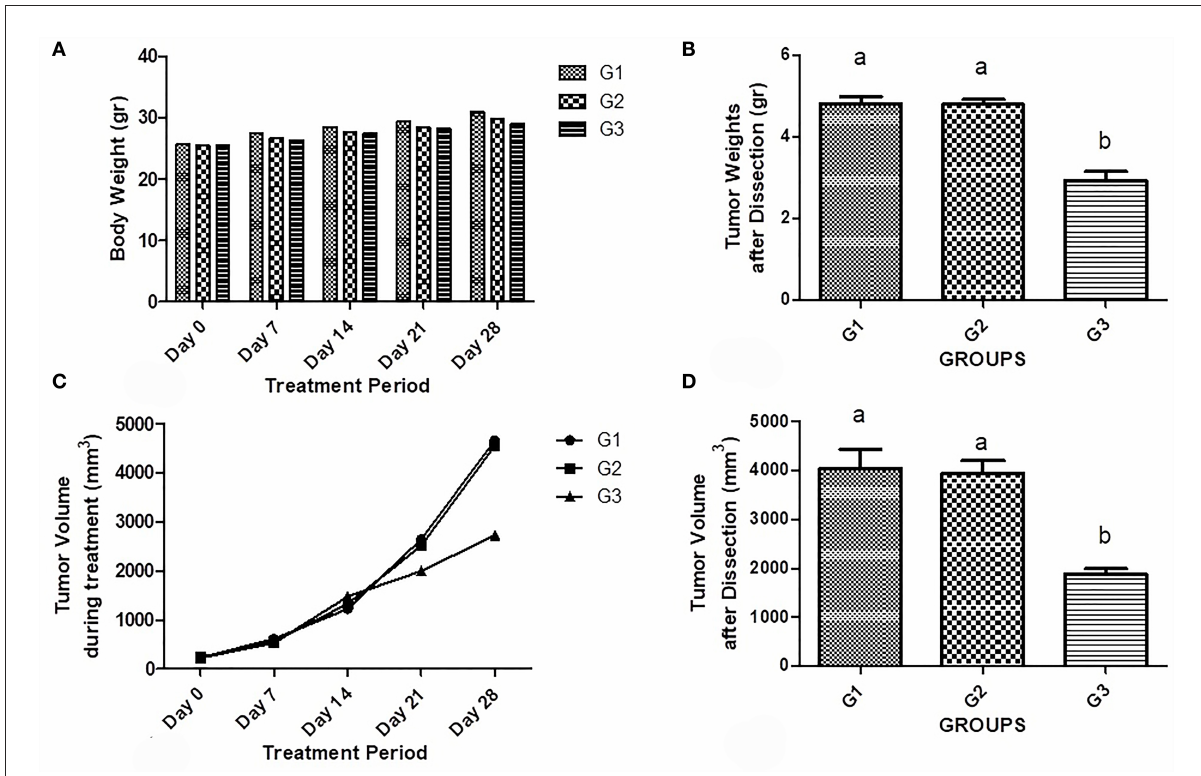
FIGURE1 Effect of bipSUR on the tumor-bearing mice. Animal weight (A) and tumor weight (B) are presented during the treatment period. All mice were gained similar weights up to the end with no significant difference. The weight of tumors in the untreated and U6-treated mice was significantly increased than the tumor weight in the bipSUR treated mice. Tumor volume during treatment (C) and at the end of experiment (D) are demonstrated. All mice showed a slight increase in tumor volume during the first 2 weeks of treatment. However, the tumor volume was significantly reduced at the end of the experiment by silencing G1 cyclins. Different letters (a and b) demonstrate significant differences among groups at P <